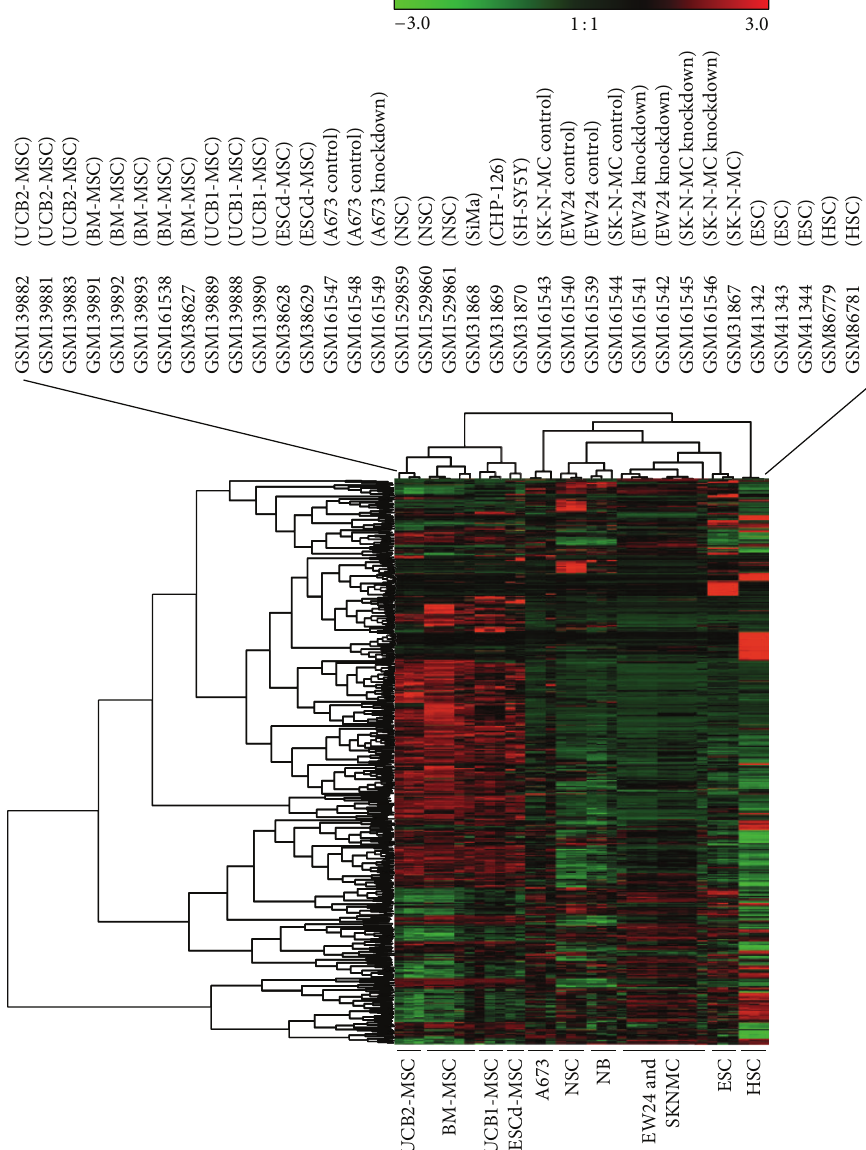
Figure 3: The stem cell signature of Ewing sarcoma cells. DNA microarray cel files from stem cells were processed as described in the caption of Figure 1. DNA microarray data from these stem cells were combined with data from a panel of neuroblastoma cell lines (NB) [1] and the Ewing sarcoma cell lines A673, EW24, and SK-N-MC [1, 3]. After RMA normalization, transformation into melodies was performed using the GEMusicA implementation in R. For this end, only the probe sets from the prefiltered stem cell signature from Figure 1 were used. The following parameters were used: minfreq = 27.5 , tonesteps = 12 , numkeys = 88 , mindur = 8 , vol = 4 , TeXscalefactor = 1 , maxNdots = 2 , and 𝑁 = 1114 . Presented is a cluster analysis of the GEMusicA-processed 1114 probe sets (Manhattan distance, complete linkage